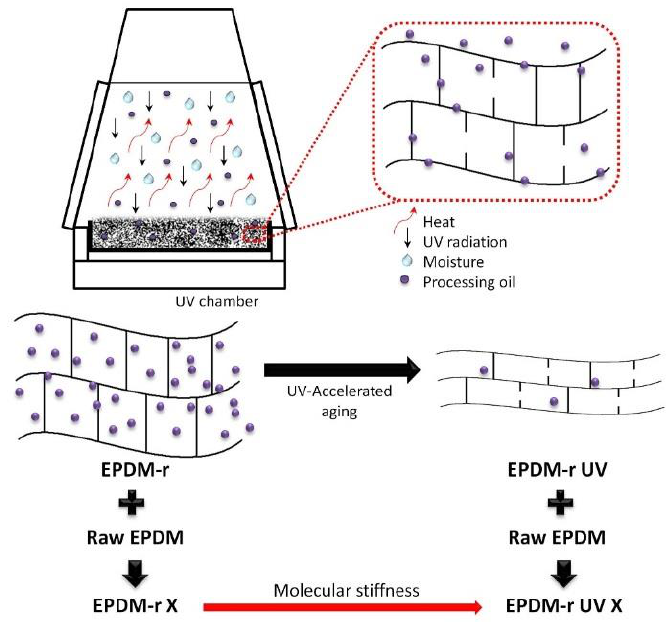
Figure 5. Schema showing the UV-accelerated aging process of the EPDM residue and its influence on the properties of the EPDM-r UV blends.